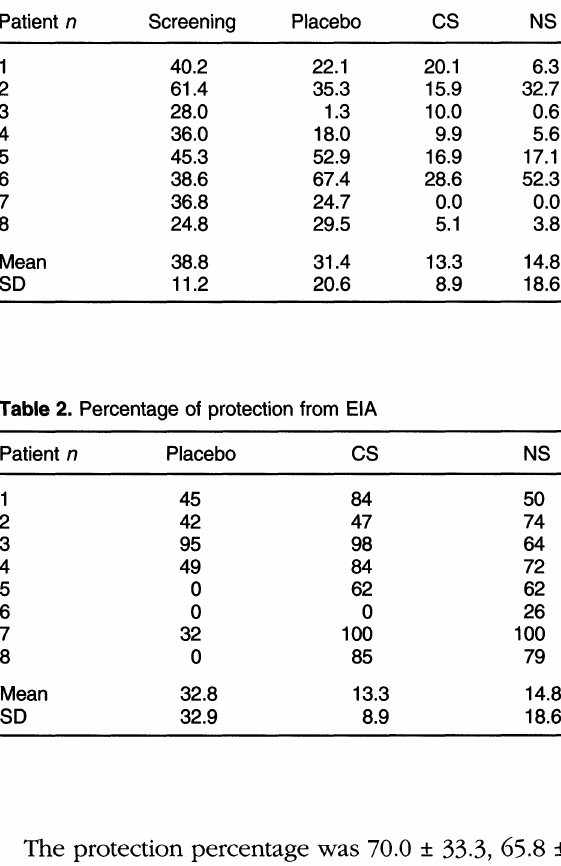
Table 1. Maximum percentage fall in FEV after exercise Patient n